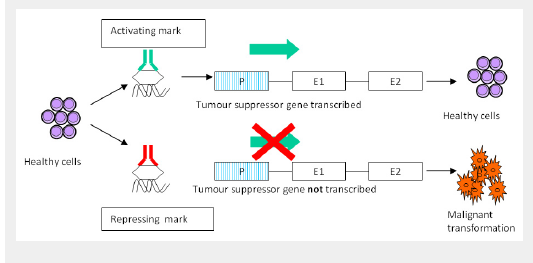
Schematic representation of epigenetics. Epigenetic changes mark the genome at specific sites acting as switches that determine whether a particular gene is transcribed (switch “on”) or not (switch “off”). In the figure an activating mark results in normal transcription of a tumour suppressor gene and maintenance of normal cell phenotype whilst a repressing mark in the same gene results in lack of transcription and malignant transformation of that cell line. Abbreviations: P: promoter; E: